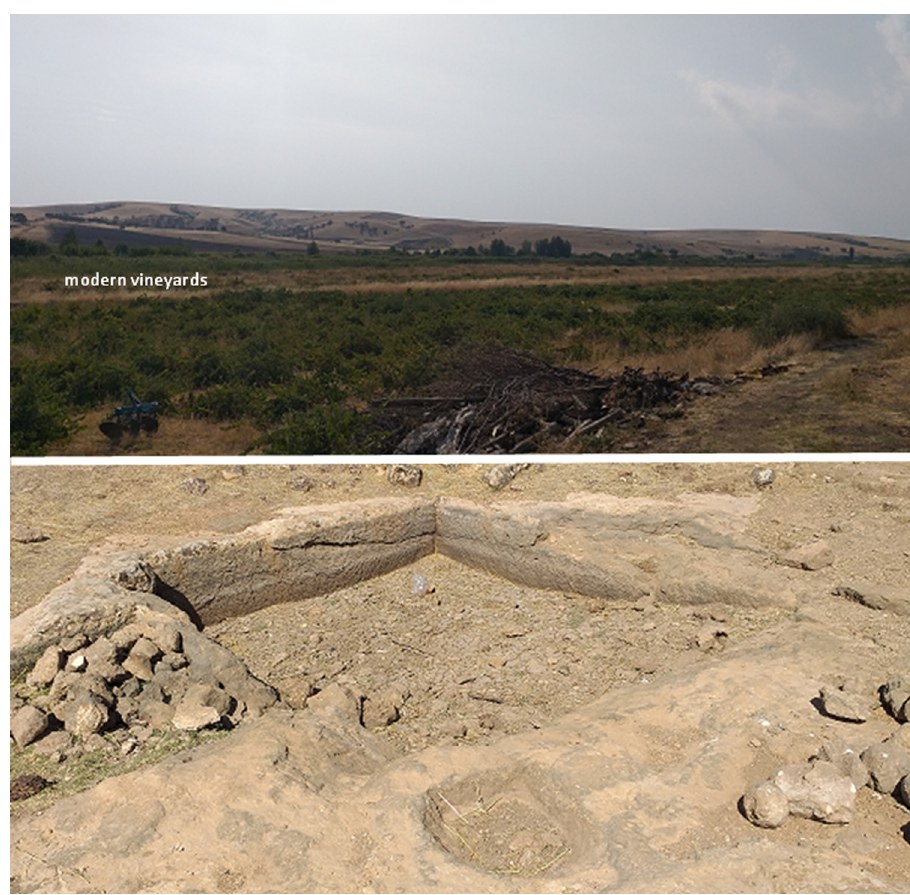
Figure 13: Modern vineyards at Ambarçay ( top ) ; ancient platform at A ş a ğı Konak Village ( below ) ( Ambarçay Salvage Excavation Archive )